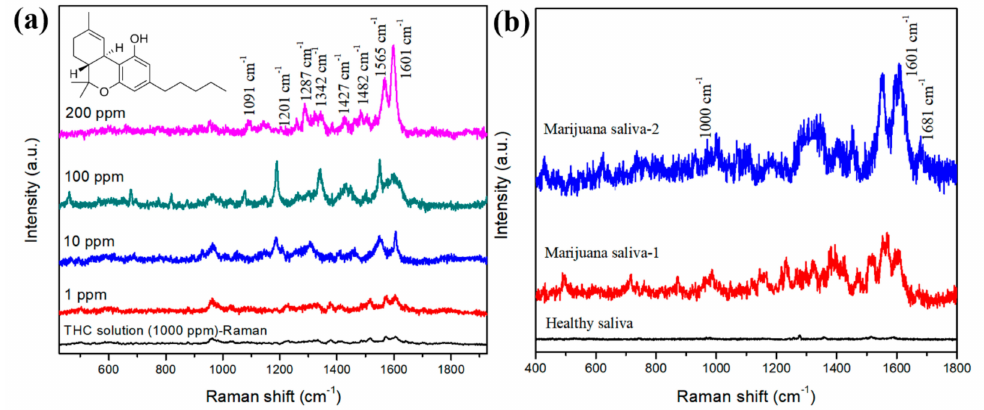
Figure 3. ( a ) SERS spectra of THC molecules (200, 100, 10, and 1 ppm) in methanol, and ( b ) SERS spectra from marijuana-users’ saliva